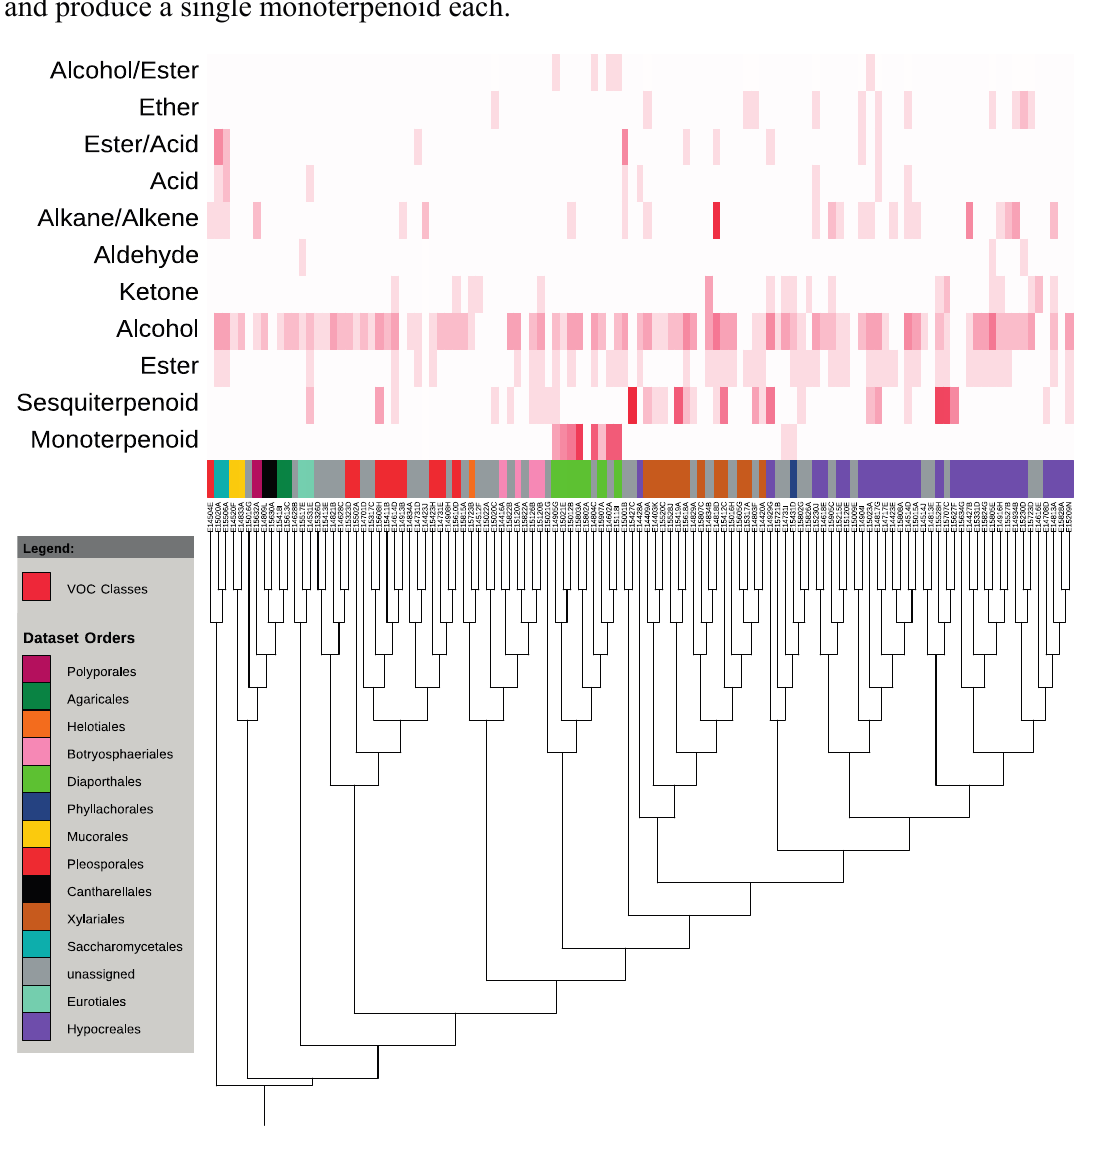
Figure 4. Maximum likelihood tree of 113 isolates analyzed on GCMS (Gas Chromatography-Mass Spectrometry). The heat map on the right indicates the number of compounds of each class produced by each endophyte. Tree was constructed in MEGA6 and visualized using the Interactive Tree of Life